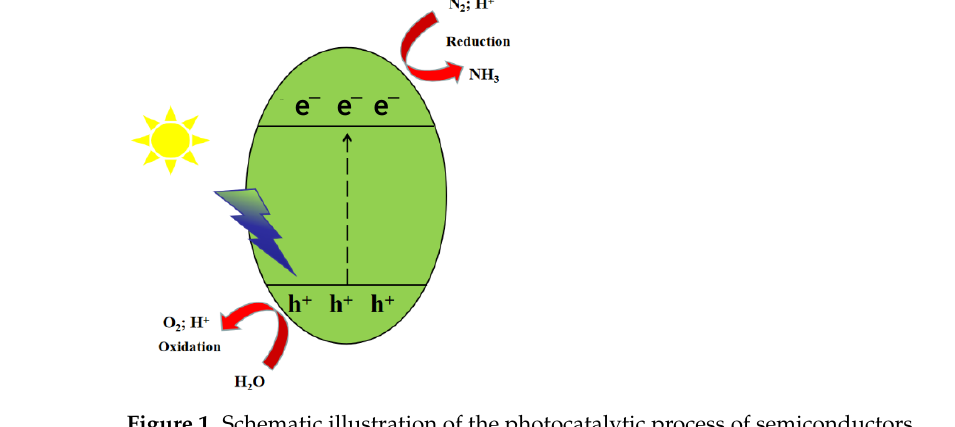
Figure 1. Schematic illustration of the photocatalytic process of semiconductors. Table 1. Nitrogen hydrogenation reaction and reduction potentials (vs. NHE at pH =